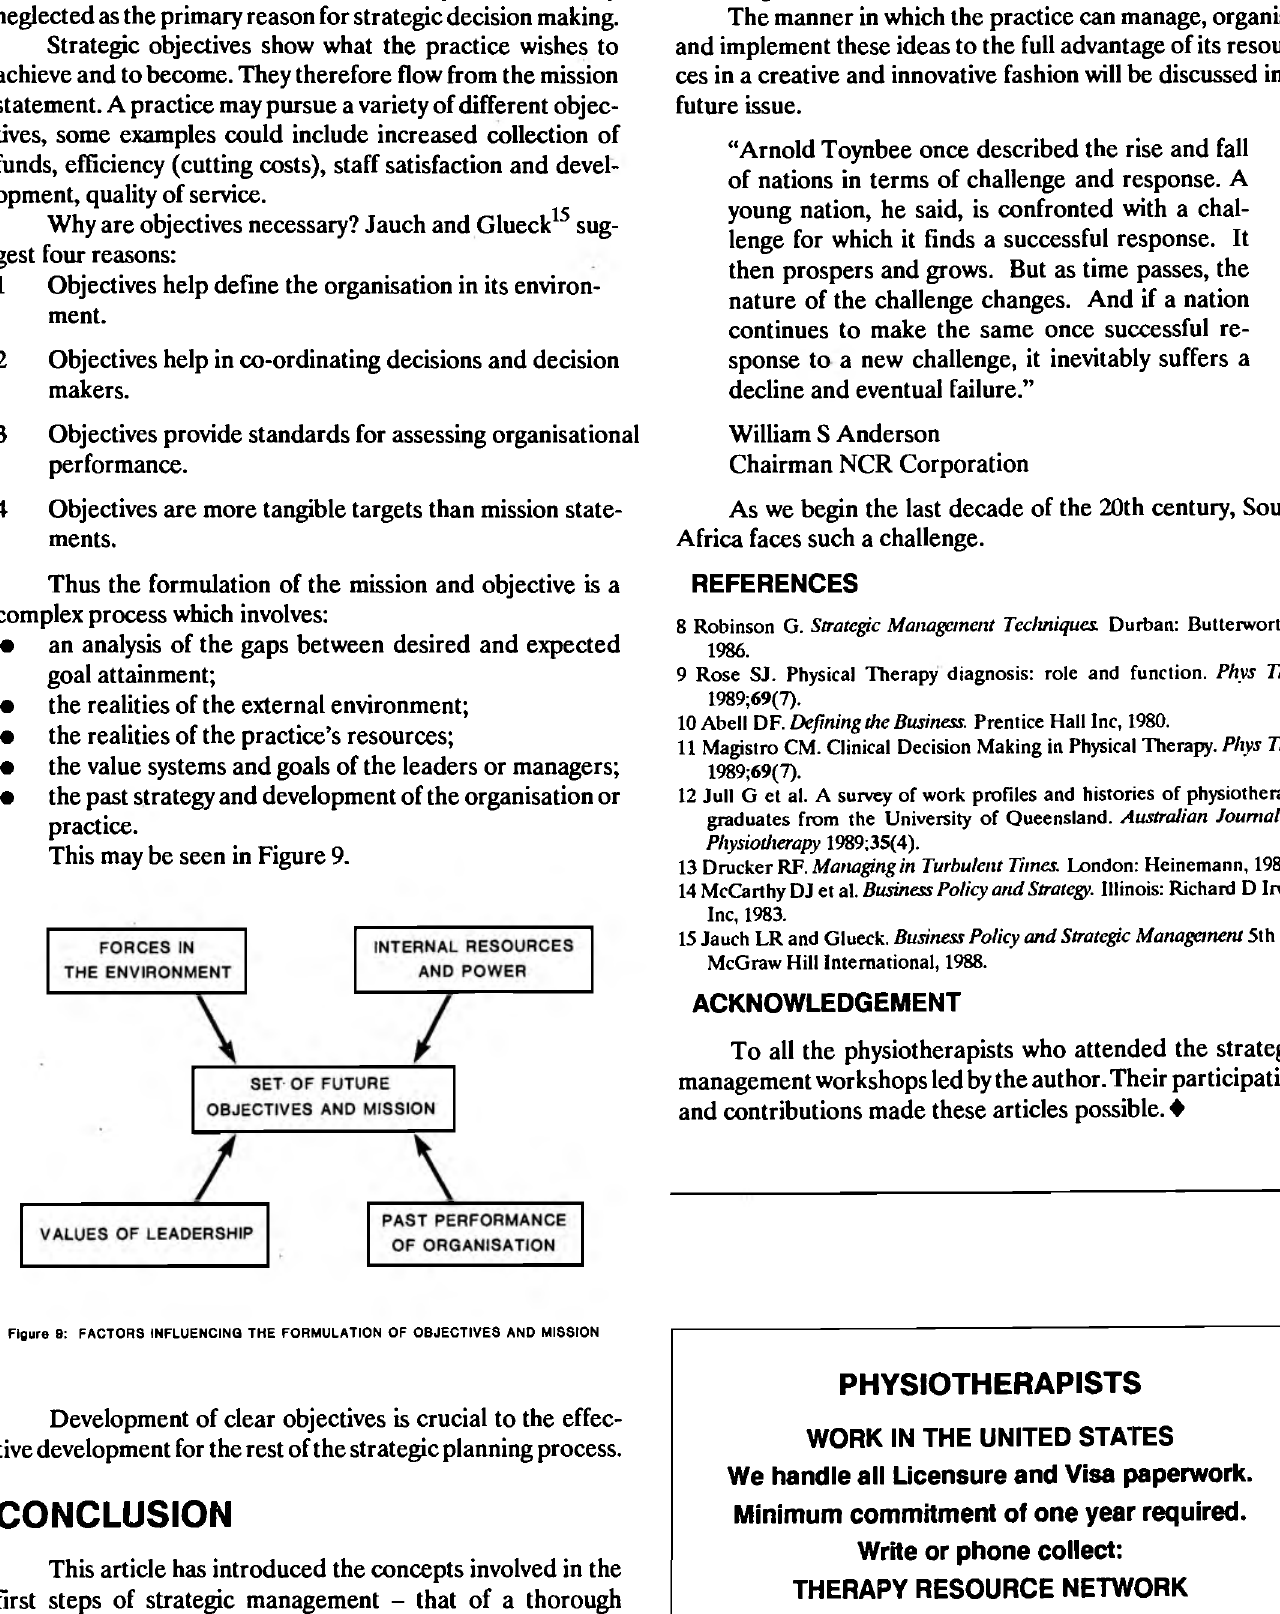
Figure S: FACTORS INFLUENCING THE FORMULATION OF OBJECTIVES AND MISSION